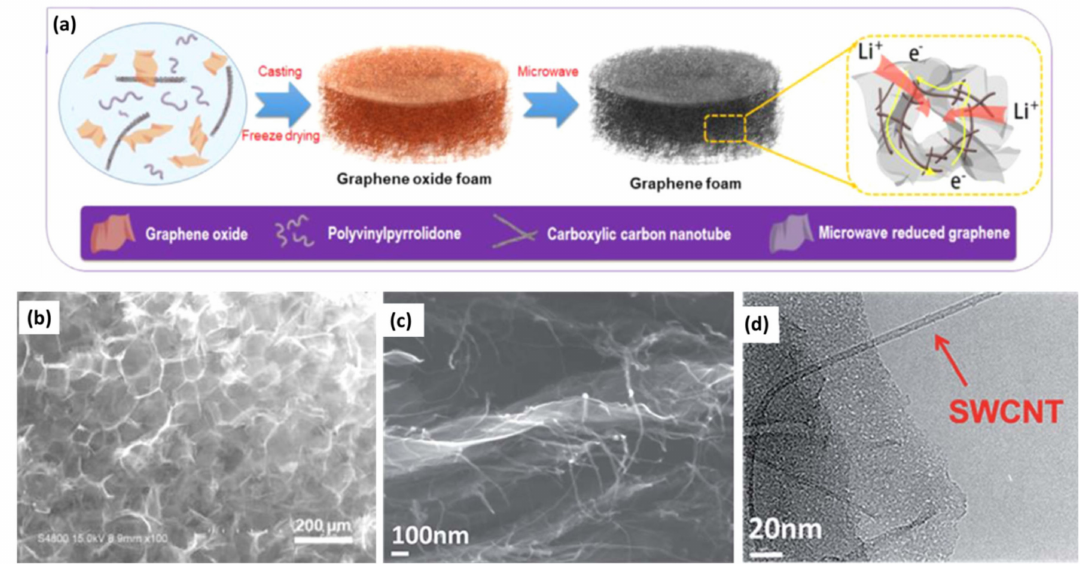
Figure 10. ( a ) The schematic illustration of preparation of GF and ( b ) SEM image of GF. (Reprinted with permission